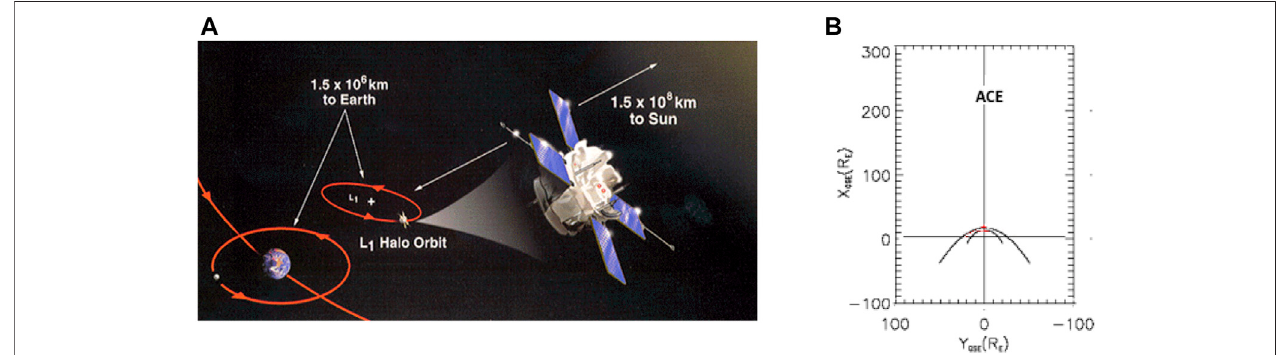
Frontiers in Earth Science |